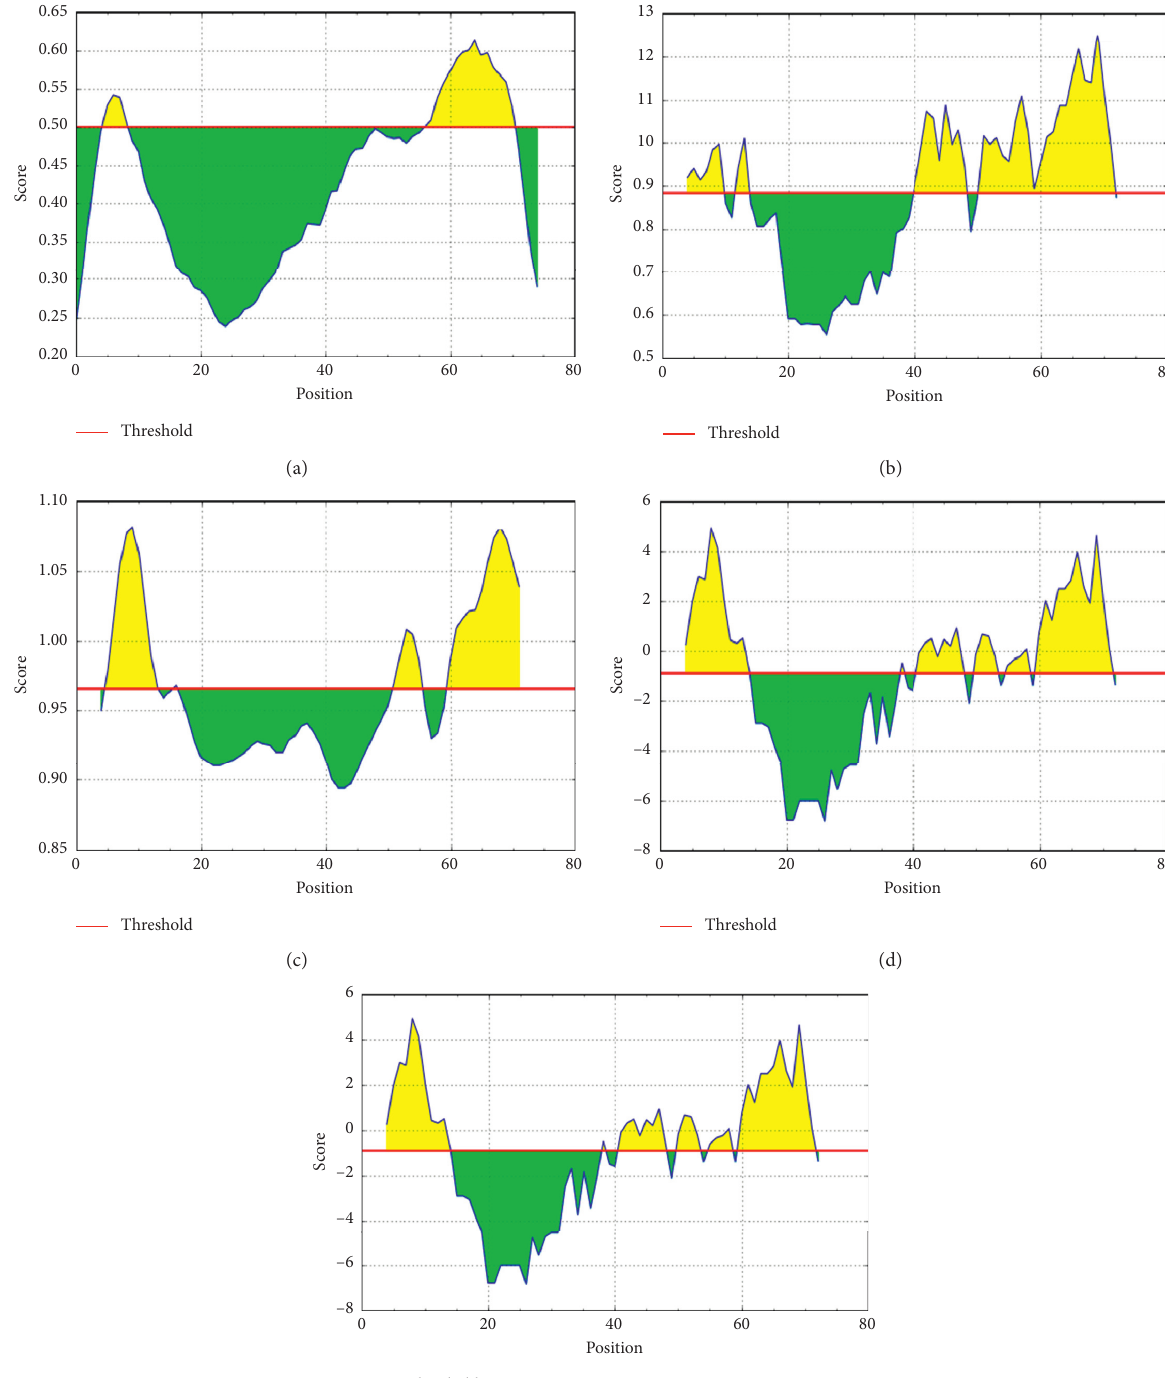
Figure 3: Prediction of B-cell epitopes by different scales/parameters (a–e). Yellow areas above the threshold (red line) are proposed to be a part of B-cell epitope. Epitope SRVKNL from 60–65 position satisfies the threshold values of all the parameters. (a) Bepipred linear epitope prediction. (b) Chou and Fasman beta turn prediction. (c) Karplus and Schulz flexibility prediction (d). Emini surface accessibility prediction. (e) Parker hydrophilicity